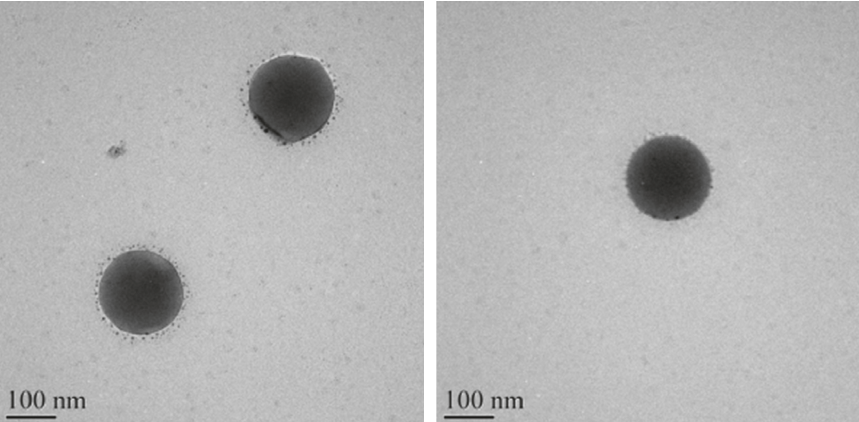
Figure 13: Transmission electron microscopy (TEM) after immobilization of collagenase onto SPS nanospheres.